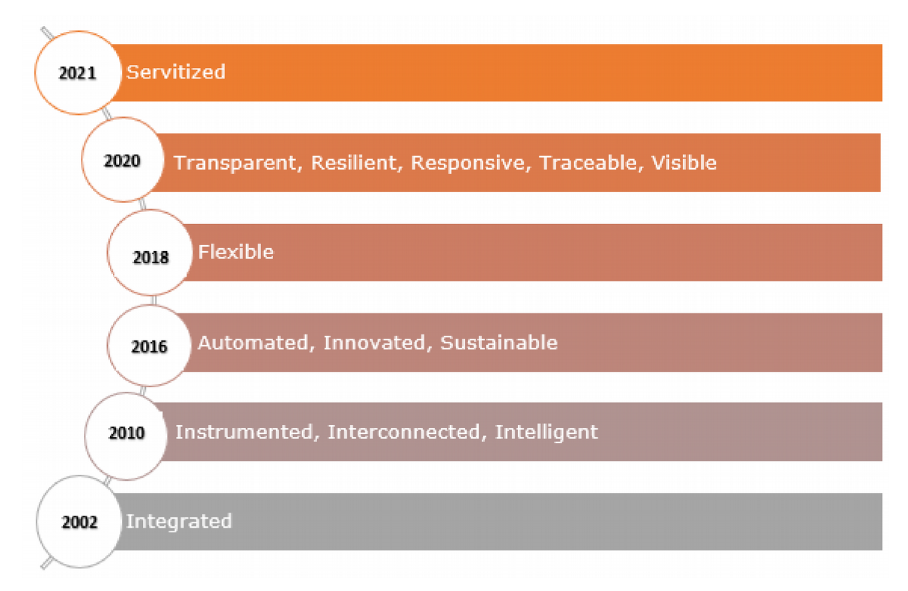
Figure 2. Evolution of the characteristics of